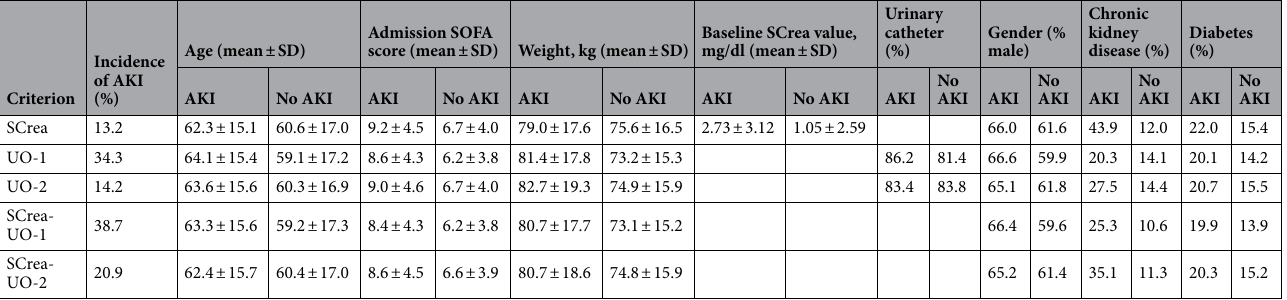
Table 2. Incidence and demographic data according to different interpretations of the criteria for KDIGO AKI stage ≥ 2. SCrea: serum creatinine > 4.0 mg/dl or > 2 × baseline, where baseline = SCrea-1 whenever available, otherwise SCrea-2, or SCrea-3 (when neither SCrea-1 nor SCrea-2 are available) with Screa-1 defined as baseline Screa measurement as manually entered in ICIS by the treating physician at ICU admission; Screa-2 defined as the lowest pre-ICU measurement up to 365 days before ICU admission as extracted from the lab information system; Screa-3 defined as a back-calculated baseline Screa using the simplified 4-variable Modification of Diet in Renal Disease (MDRD) Study equation assuming an estimated glomerular filtration rate (eGFR) of 75 ml/min/1.73 m 2 for every patient 30 ; UO-1: total UO during the last 12-h period was ≤ 6 ml/ kg; UO-2: total UO during each of the last 12 consecutive 1-h periods was ≤ 0.5 ml/kg; SCrea-UO-1: AKI stage ≥ 2 according to either the SCrea criterion or the UO-1 criterion; SCrea-UO-2: AKI stage ≥ 2 according to either the SCrea criterion or the UO-2